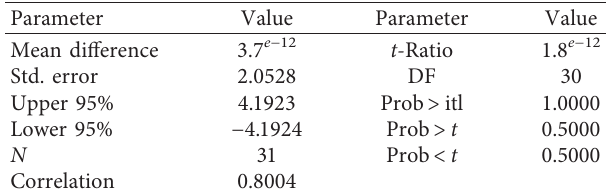
Table 4: Mean difference between methods and correlation analysis from the Bland–Altman